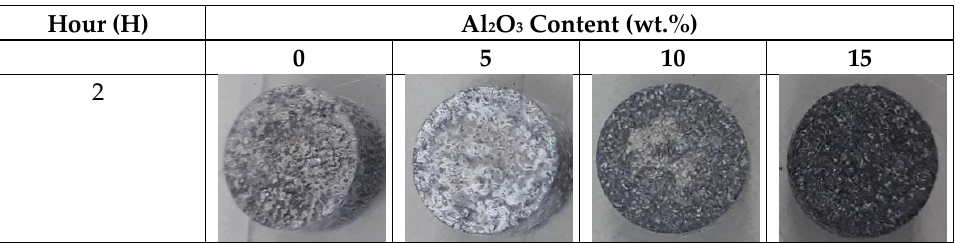
Figure 8. Images of corrode Mg-Zn/HAP/Al 2 O 3 after an immersion test of 2 and 4 h in HBSS solution.